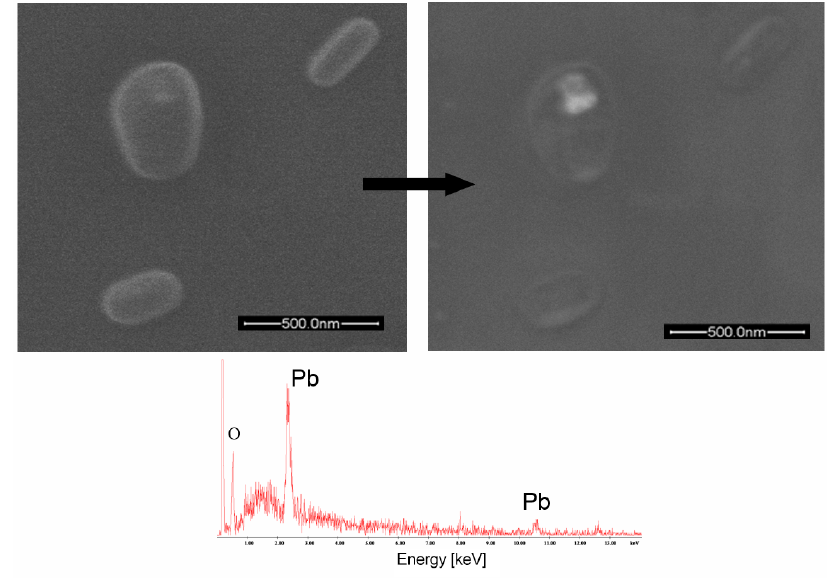
Figure 5. Left: three secondary particles containing different amounts of sulfates/nitrates/organics at the beginning of electron microscopic investigation. Right: under electron bombardment the material evaporates after a few seconds exhibiting a lead-rich inclusion.